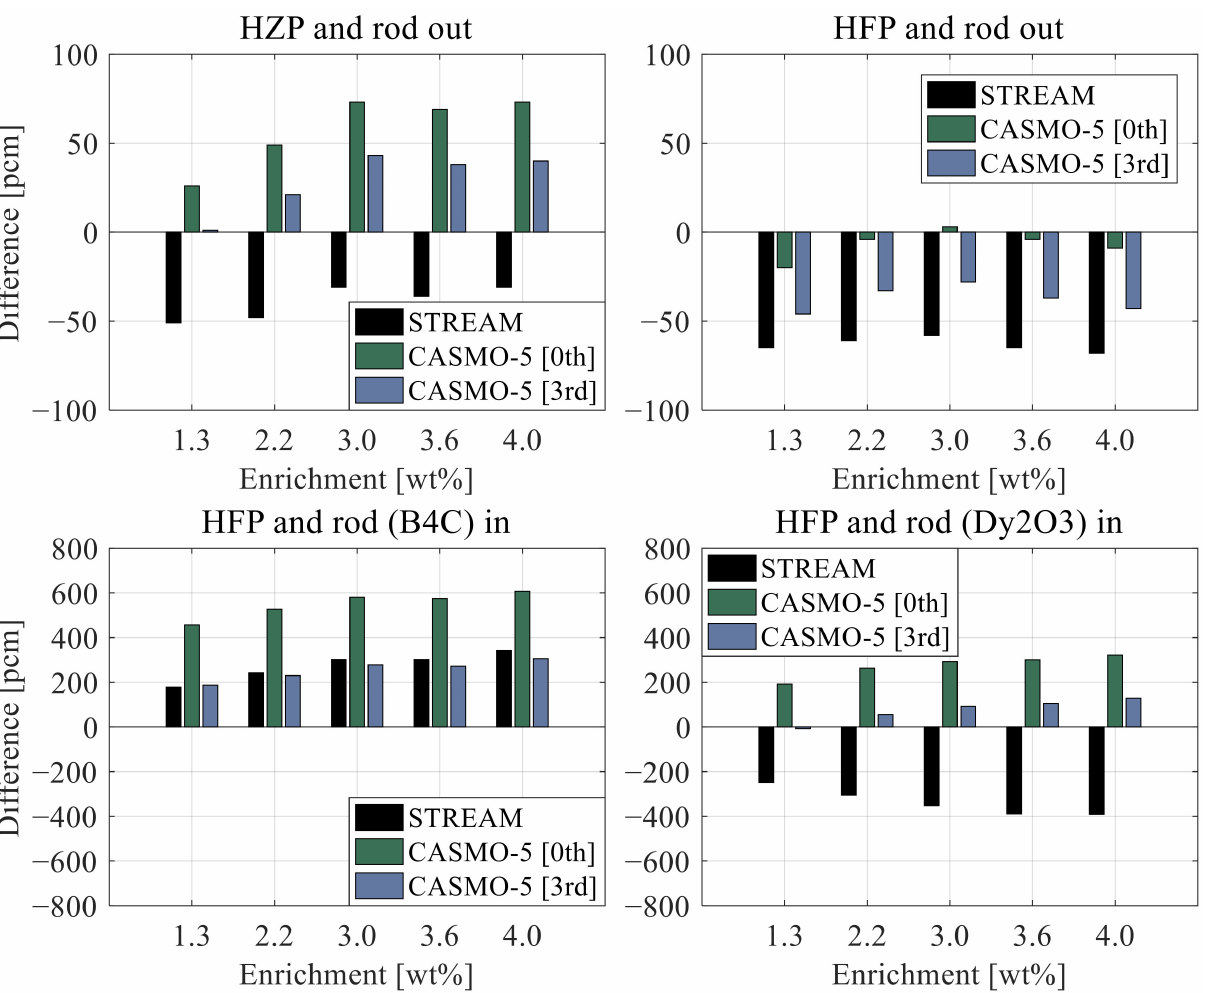
Figure 11. Multiplication factors of STREAM and CASMO-5 in various simulation